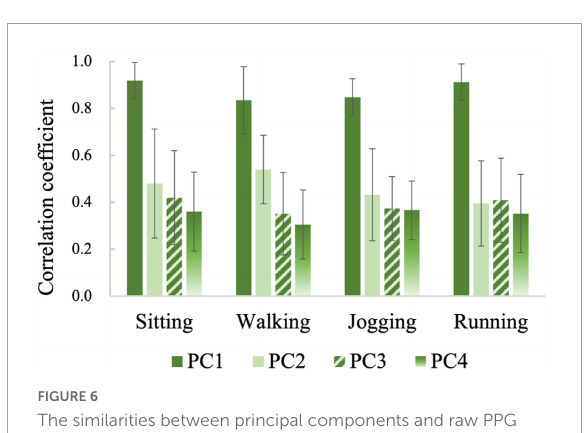
FIGURE6 The similarities between principal components and raw PPG signals.